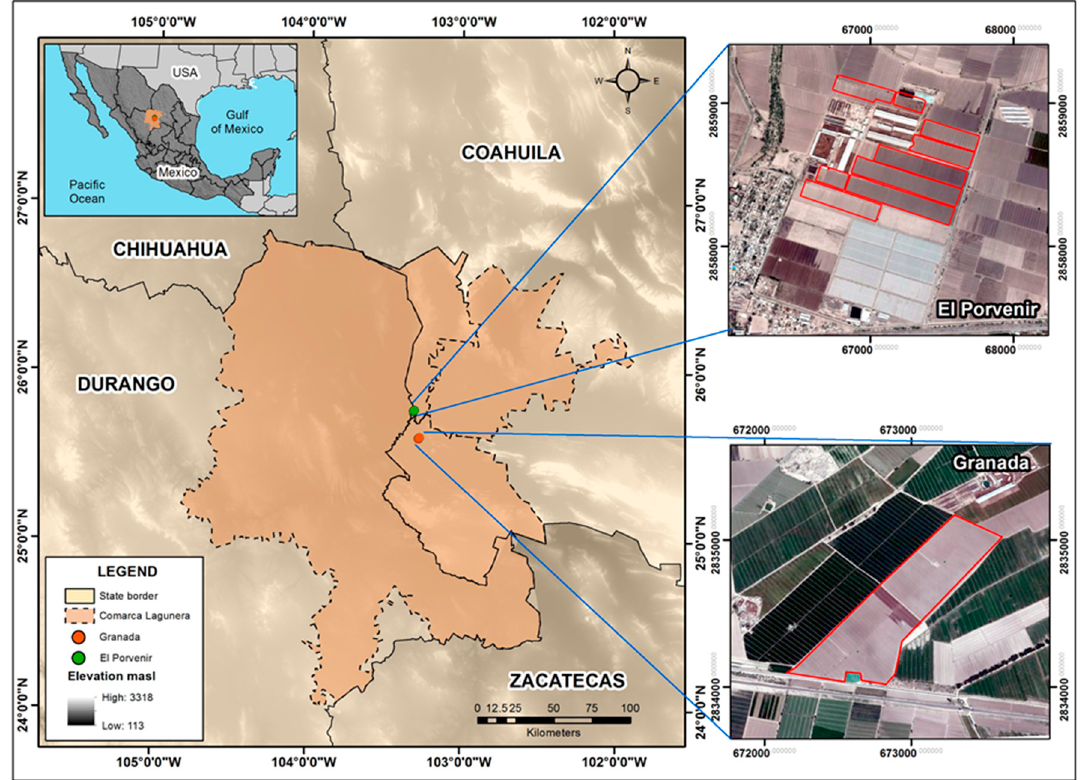
Figure 1. Study area location. The sample sites were recorded with a geographical information system.